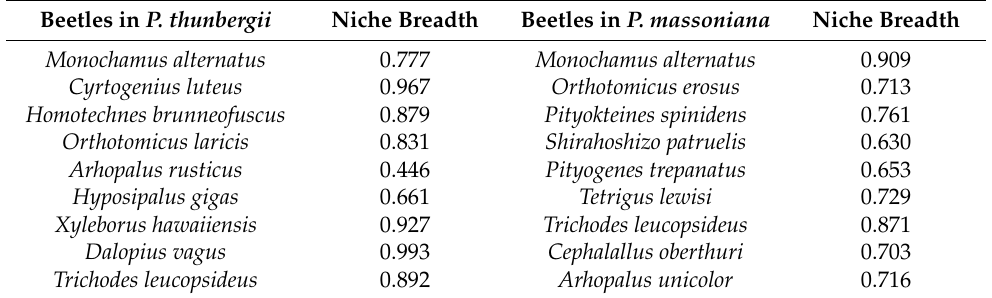
Table A2. Niche breadth of xylophagous beetles in the infected P. thunbergii and P. massoniana .